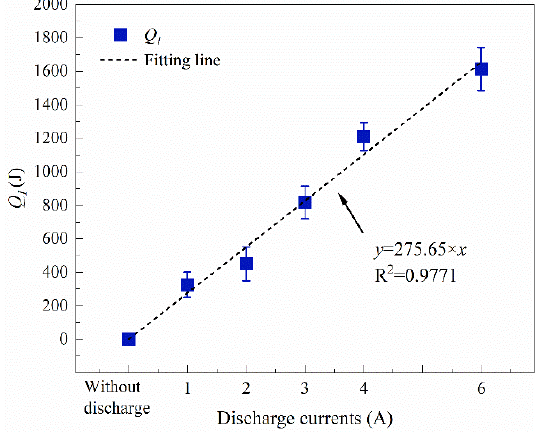
Figure 13. Total energy produced inside the battery vs. discharge current.